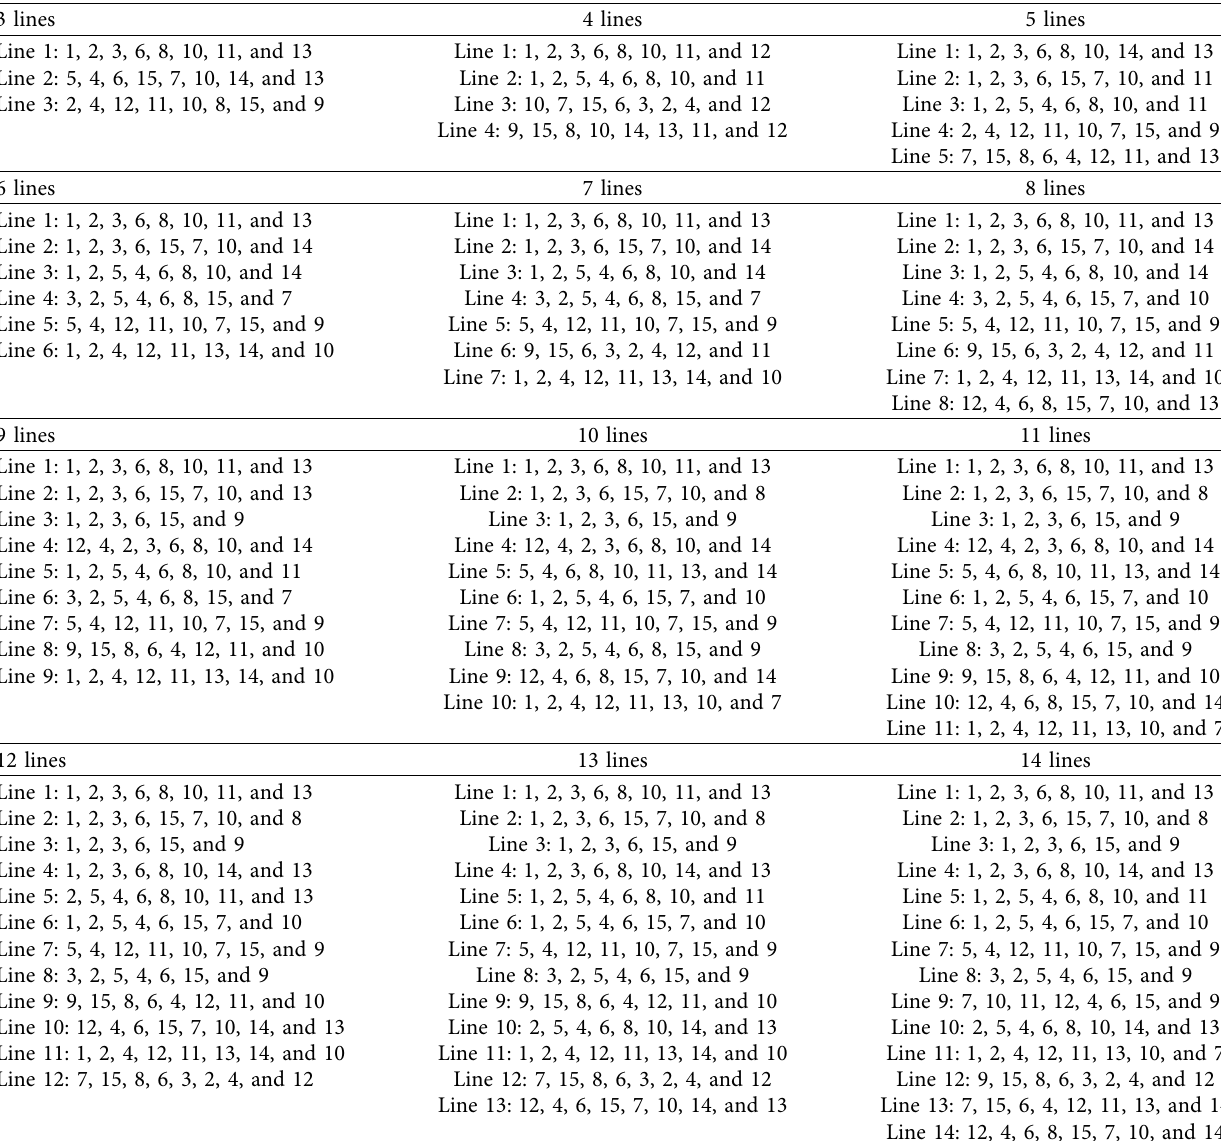
Table 2: Optimal solutions for 3 to 14 lines with at most 8 nodes per